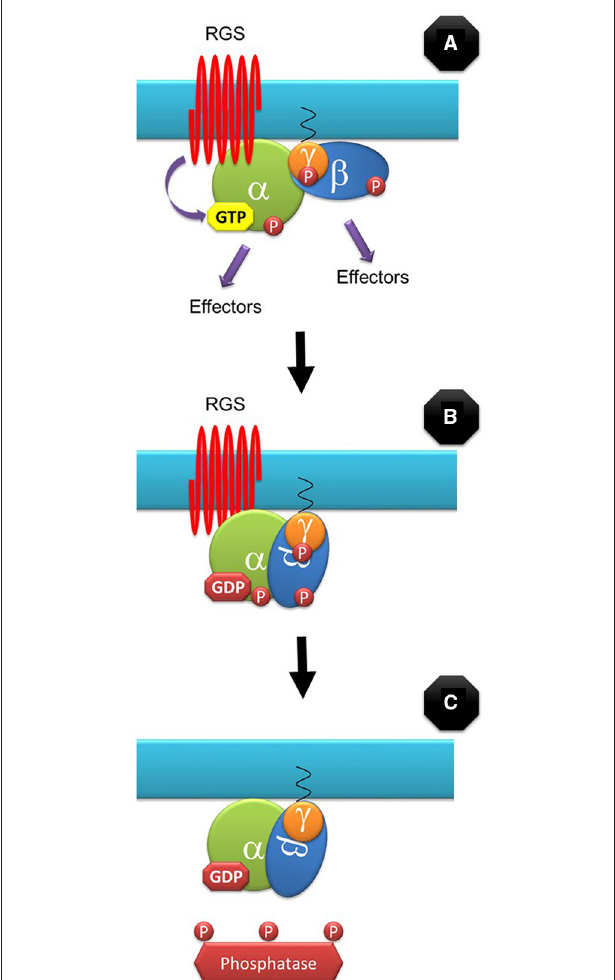
FIGURE 2 | RGS-dependent signaling control. For some signaling events, the G-protein cycle can be short-circuited by RGS by stimulating the GTPase activity of the canonical G α subunit (A) . GDP-bound G protein conformation does not allow interaction with downstream effectors and it is therefore inactive, independently of its phosphorylation state (B) . Eventually, phosphatases will de-phosphorylate the subunits before they can bind GTP again (C)